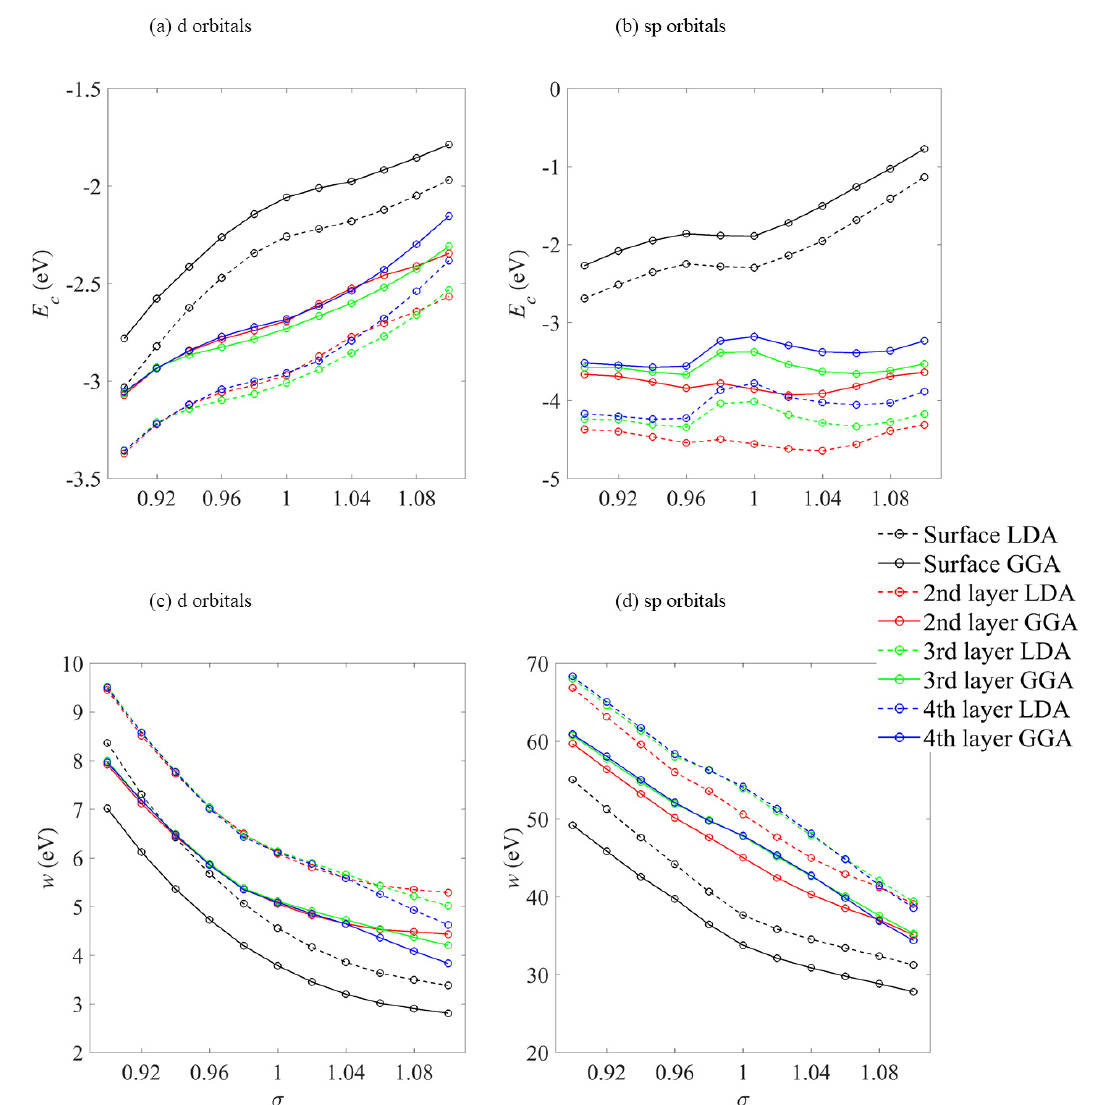
Figure 8. Layer-resolved band centre E c and width w for the d and sp bands on an 7-layer Pt(111) slab. The dashed (solid) lines correspond to estimates made using the LDA (GGA) exchange-correlation functional.